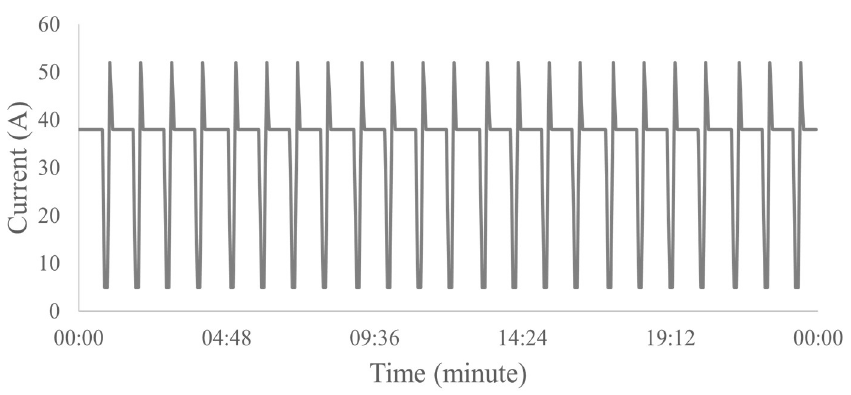
Figure 8. Example of a simulated 24 h gas locking well.